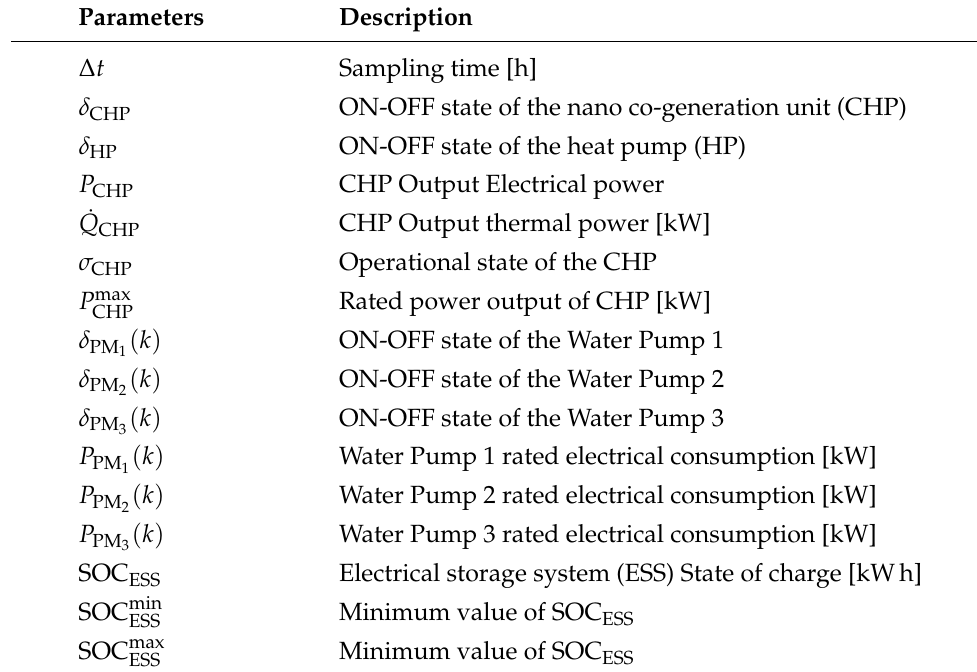
Table 1. System model